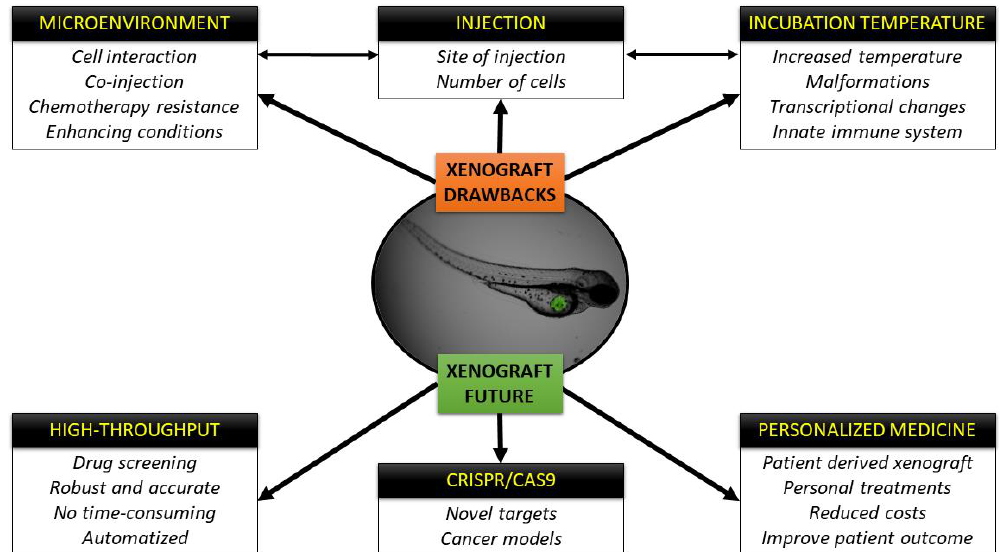
Figure 2. Schematic representation of the drawbacks of the xenograft technique and future perspectives and fields of application.